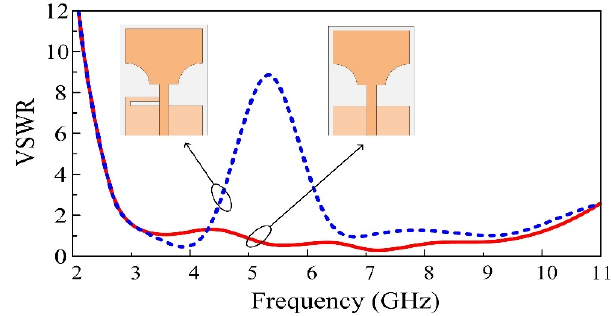
Figure 4. Comparison between UWB and WLAN notch band antennas.